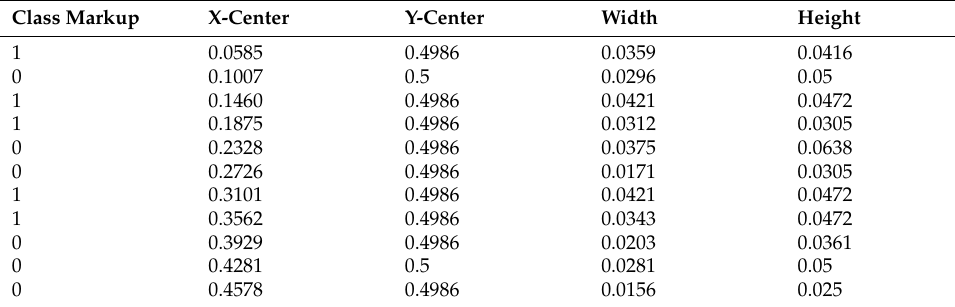
Table 1. The sample of synthetic image label storage format.